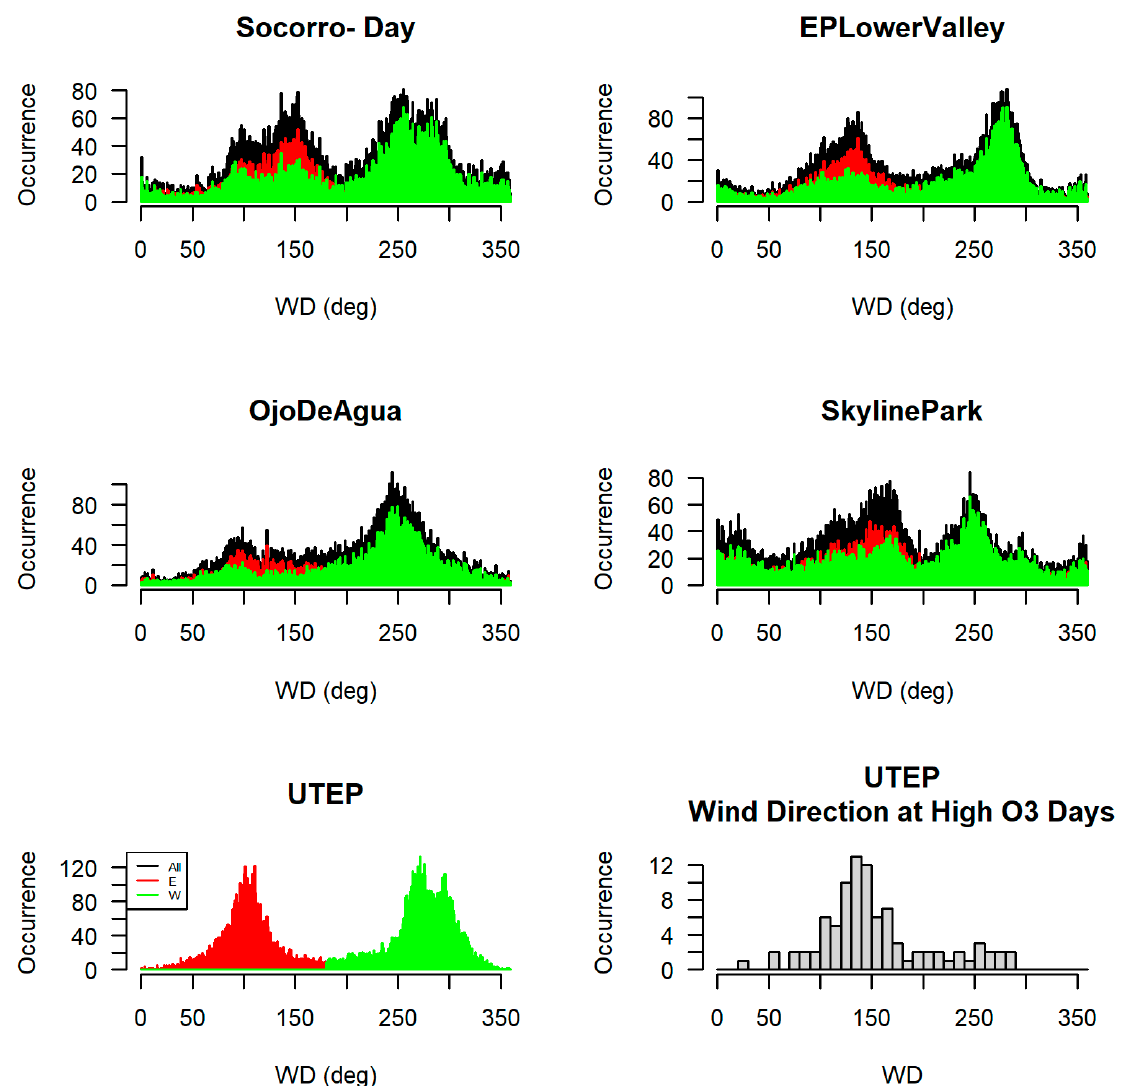
Figure 7. Histograms of the horizontal meteorological wind directions during the 2016–2018 for TCEQ CAMS Socorro, El Paso lower valley, Ojo De Agua, Skyline Park, and UTEP. The red and green correspond to the Easterly and Westerly wind direction at the UTEP CAMS, respectively. The bottom right corner plot shows the wind direction histogram for high ozone days (O3 > 70 ppbv) at UTEP CAMS.